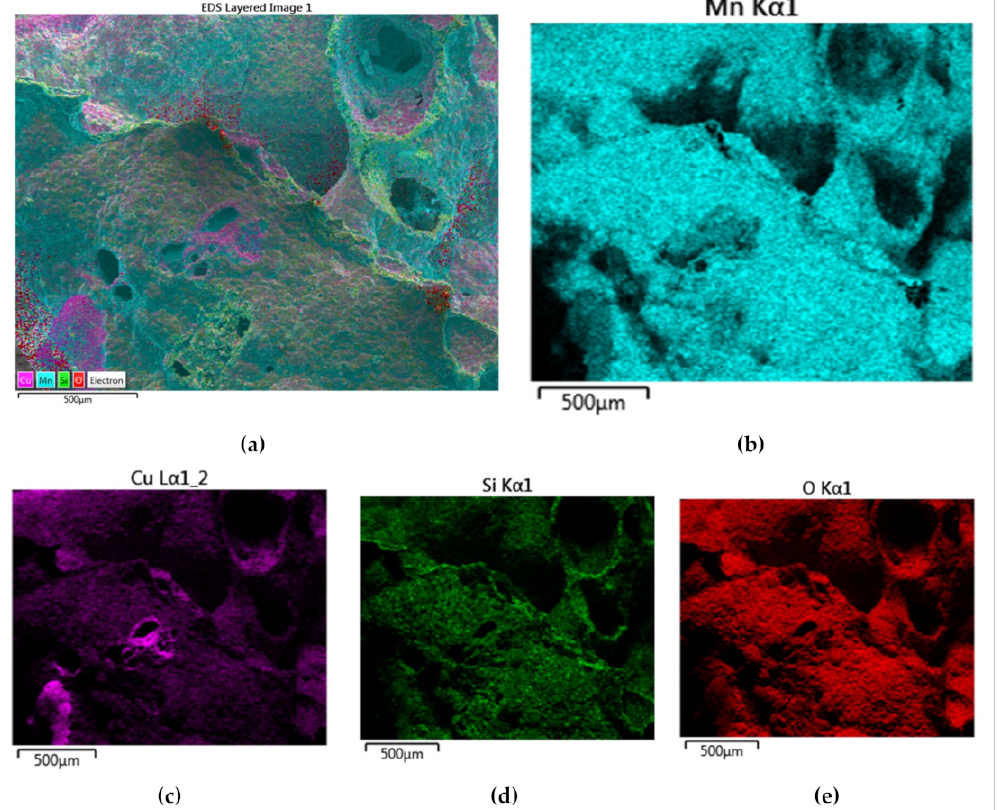
Figure 35. EDS image and elemental mapping of Mn / Cu / Si = 1 / 0.5 / 1 catalyst obtained after 60 s of extra microwave irradiation at 1800 W of the fresh catalyst described in Figure 34. ( a ) EDS image with composition [Mn] = 0.217, [Cu] = 0.181, [Si] = 0.118, [O] = 0.484; ( b ) Mn-mapping; ( c ) Cu-mapping; ( d ) Si-mapping; ( e ) O-mapping. Scale bar = 500 µ